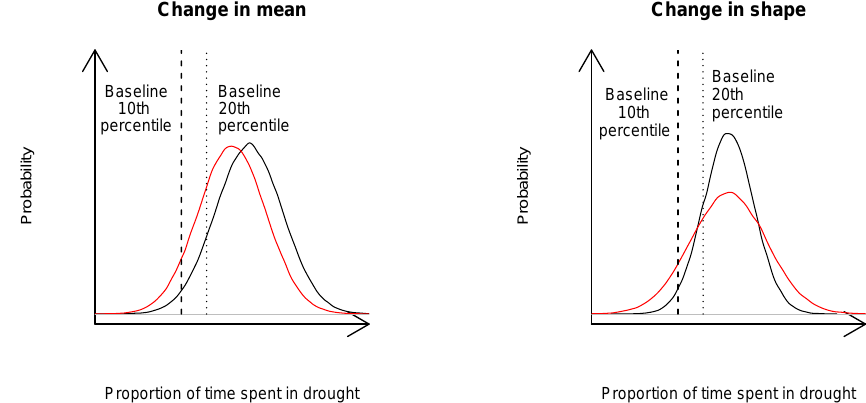
Fig. 1. Schematic of drought threshold. The black line represents a sample baseline distribution and the red line a sample future